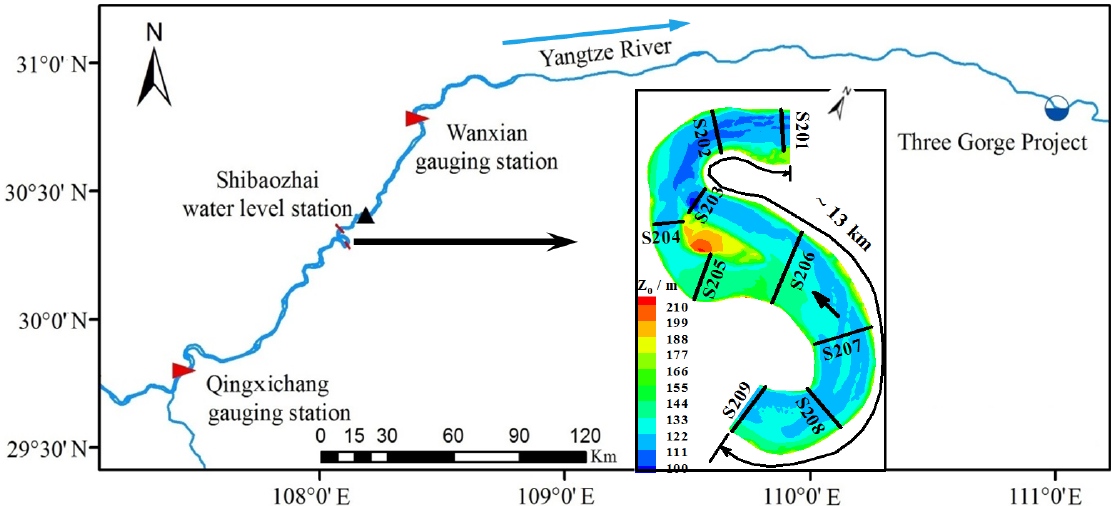
Figure 2. Planform geometry, bed elevation ( Z 0 ) on March 2012 and nine cross-sections measured in HHC reach (S209 and S201 are the inlet and outlet boundaries, respectively; incoming flow discharge and sediment concentration used as inlet boundaries are interpolated from Qingxichang and Wanxian gauging station, located upstream 476.46 km and 291.38 km from TGP, respectively; and the outlet boundary applies the water stage measured at Shibaozhai station, located upstream 341.35 km from the TGP).